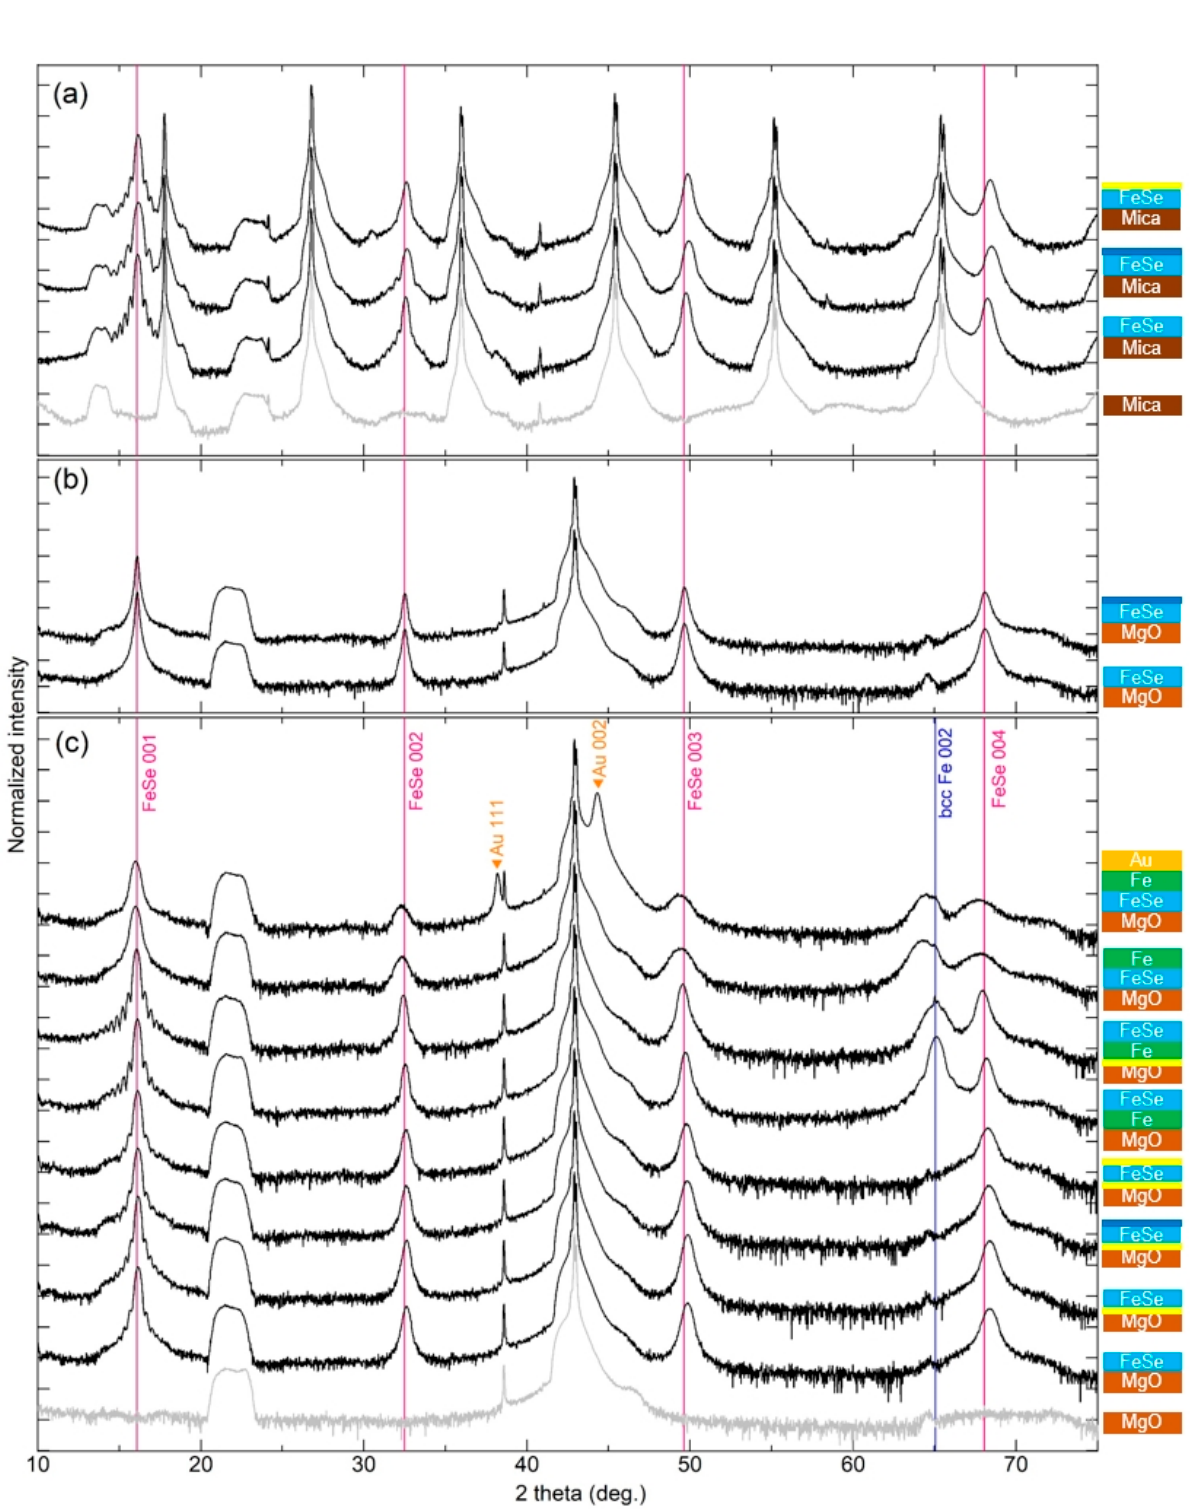
Figure 1. 2 θ / ω scans of ( a ) FeSe/Mica, ( b ) FeSe/MgO deposited at low growth rates, and ( c ) FeSe/MgO, FeSe/Fe/MgO, Fe/FeSe/MgO, and Au/Fe/FeSe/MgO films with mica and MgO references (shown as grey lines). Intensities were normalized with respect to the MgO (002) reflection in the films deposited on MgO and to mica(003) reflection in the film deposited on mica, respectively. Schematic images of the films corresponding to the neighboring 2 θ / ω scans are illustrated at the right side. Yellow lines at the FeSe/MgO and Fe/MgO interfaces represent the MgO substrate pre-annealed in Se vapor. Dark blue and yellow lines at the film surface depict the films post-annealed in UHV and Se vapor, respectively.